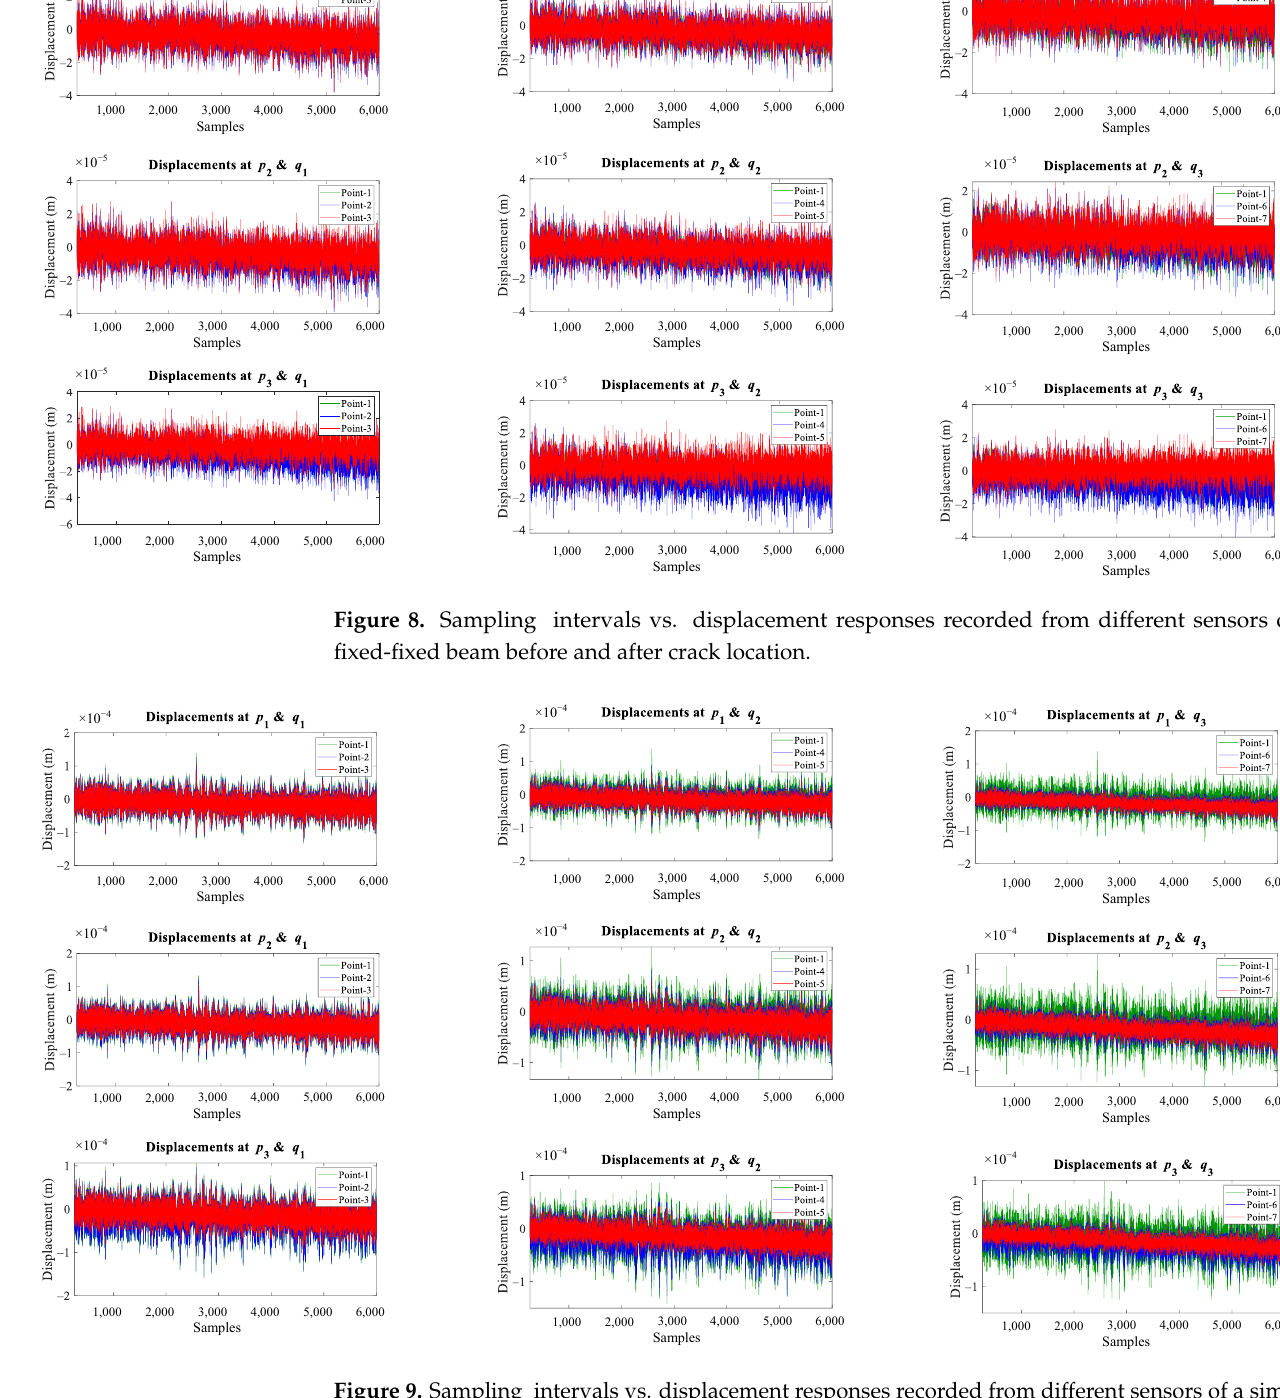
Figure 9. Sampling intervals vs. displacement responses recorded from different sensors of a simply supported beam before and after crack